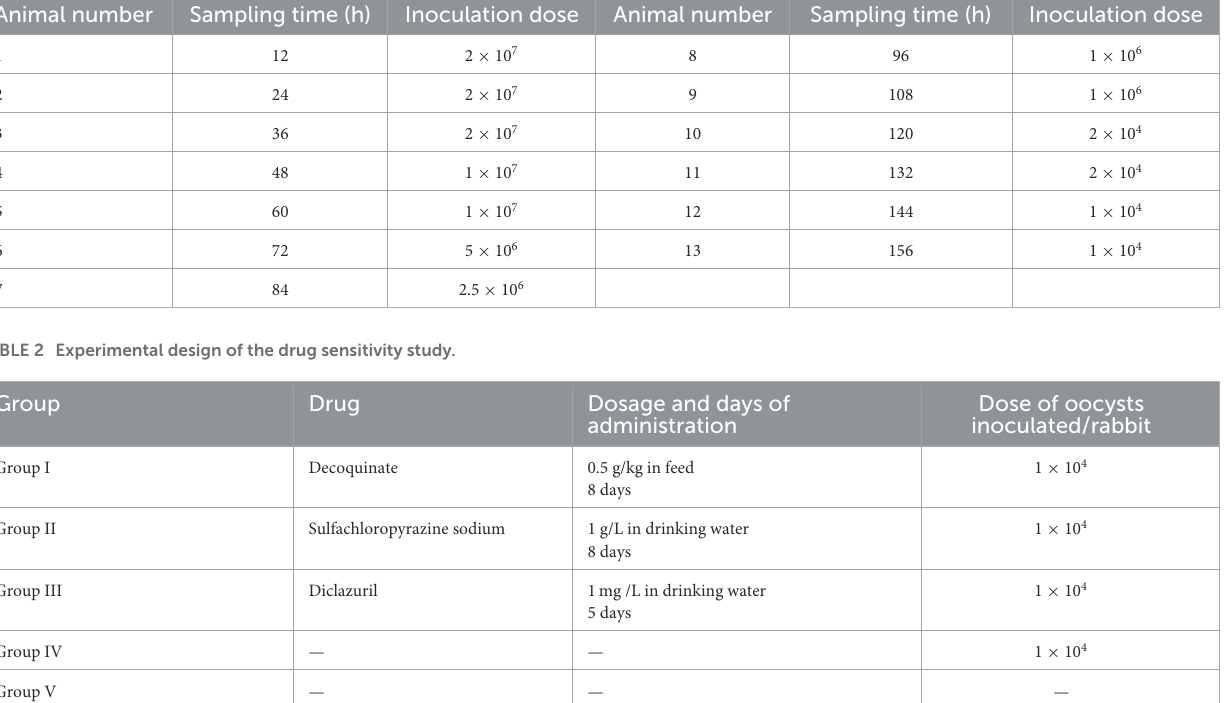
TABLE 1 Inoculation doses and time of sacrifice after infection. Animal number